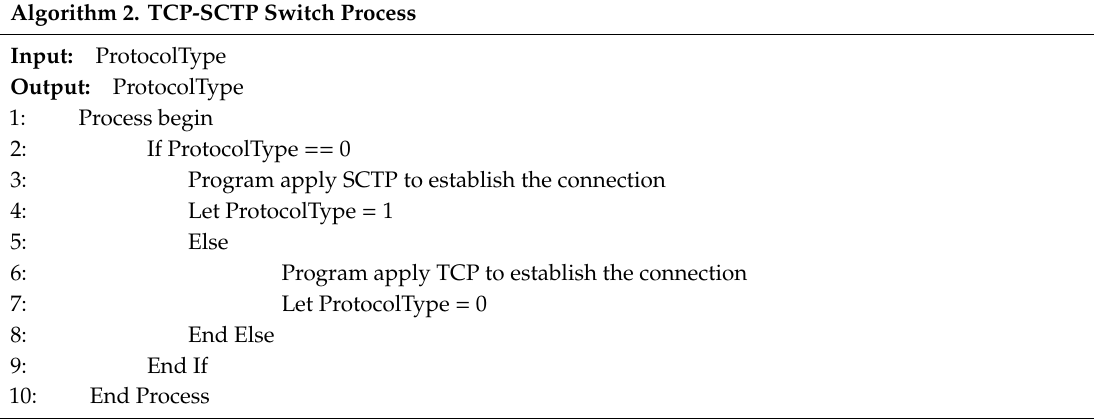
Algorithm 2. TCP-SCTP Switch